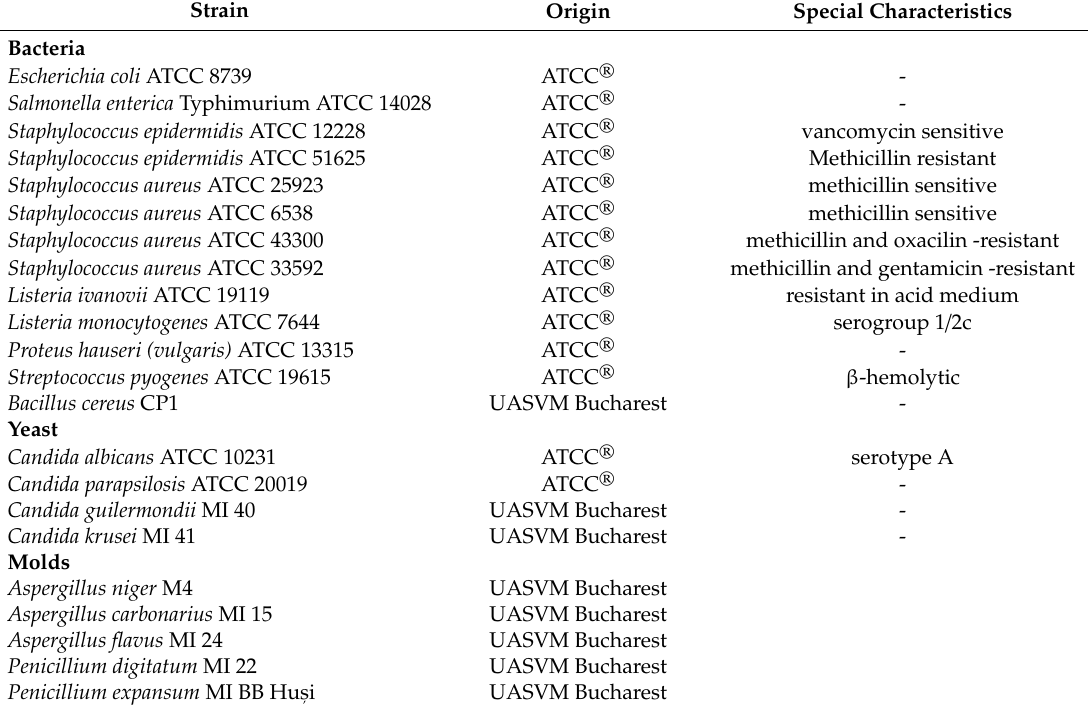
Table 1. Pathogenic microorganisms used in the antagonistic